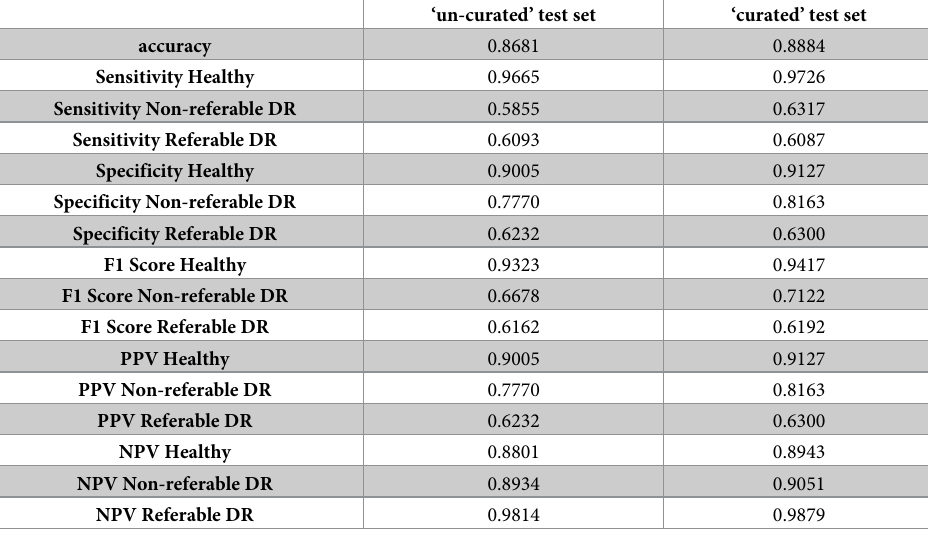
Table 3. Performance of the DRCNN based on three grades (healthy, non-referable, referable). ‘un-curated’ test set ‘curated’ test